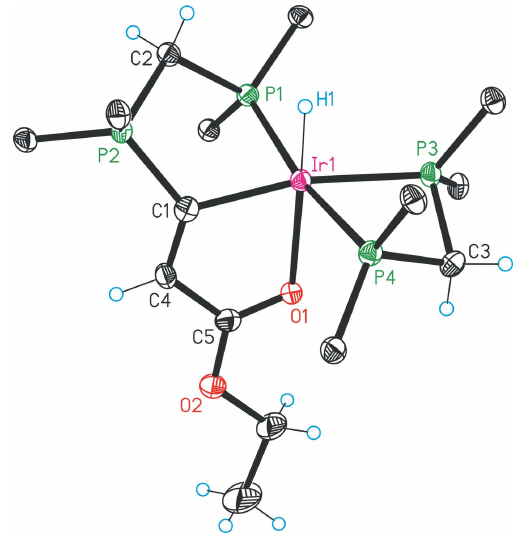
Figure 1 Structure of complex 3 with displacement ellipsoids drawn at the 30% probability level. For clarity, only the ipso carbon atoms of the phenyl groups are shown and the counter-ions are